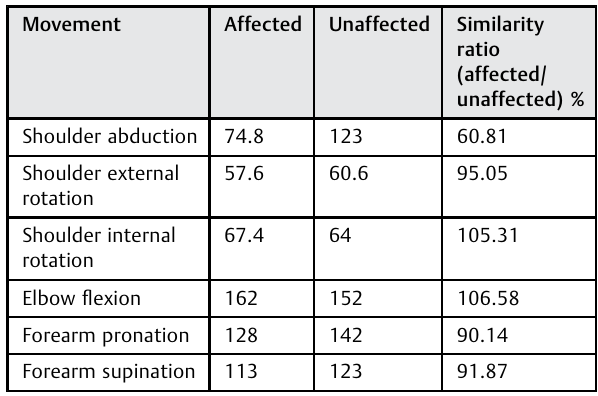
Results for comparing the ratio of angular displacement of active motion between affected and unaffected limbs in upper extremity movements (cm)